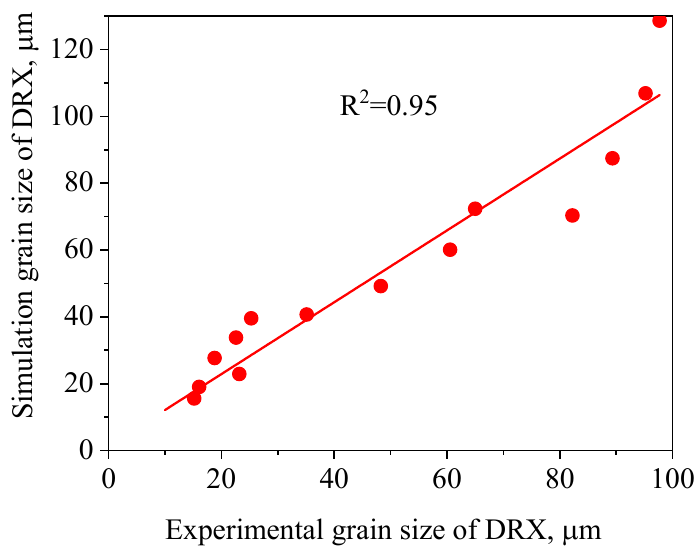
Figure 13. Correlation between the FEM and experimental grain size of DRX for 47Zr-45Ti-5Al-3V alloys after hot deformation.